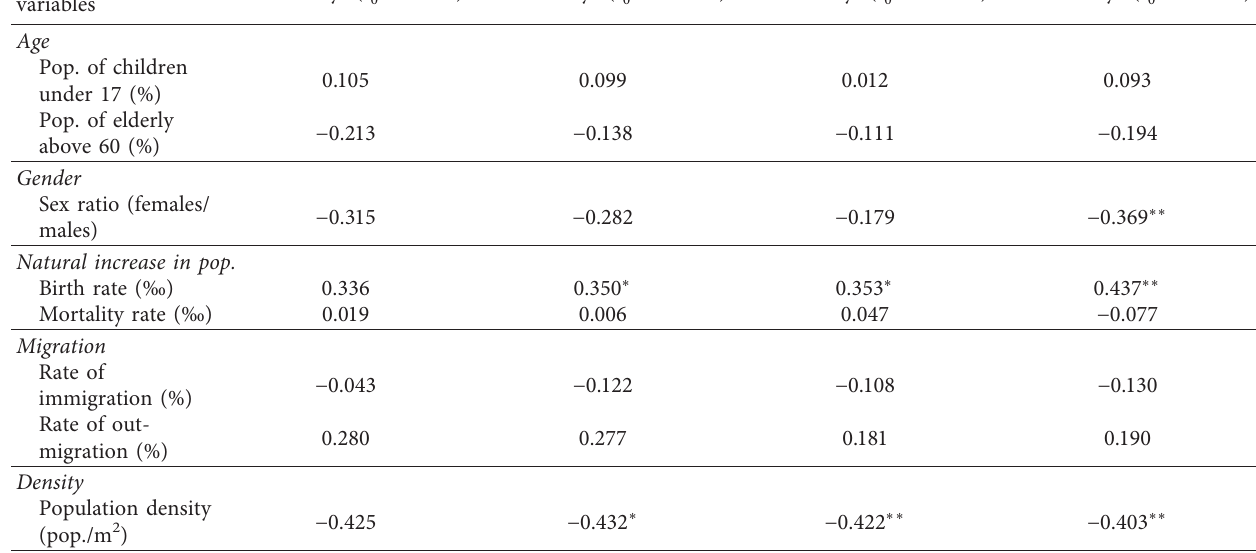
Table 2: Bivariate correlation between accessibility and demographic